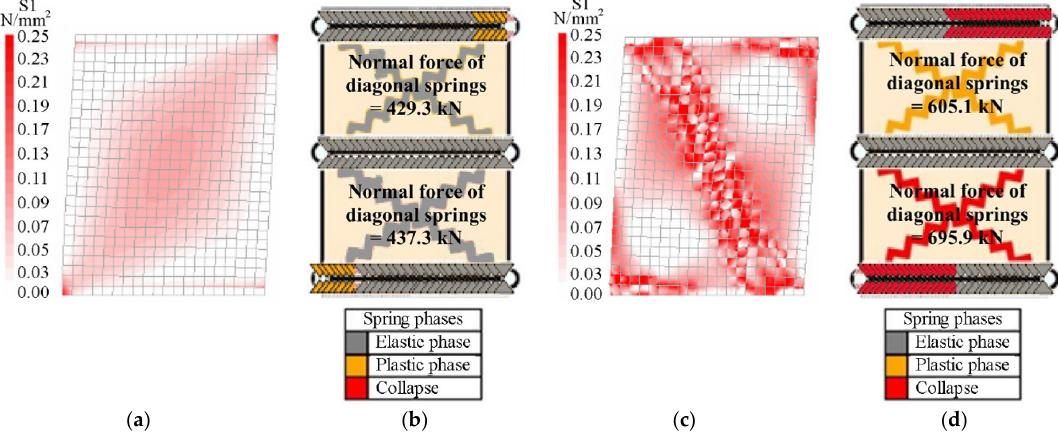
Figure 7. Distributions of the principal stresses and normal forces into the squat masonry panel at the end of the elastic field: ( a ) FEM, ( b ) DMEM, and at the peak load step: ( c ) FEM, ( d ) DMEM.